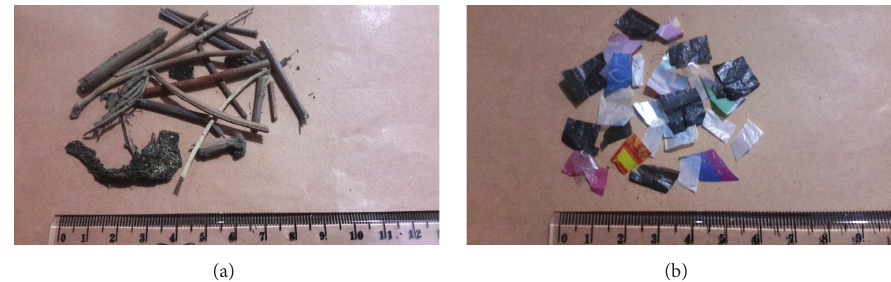
Figure 1: (a) Rough organic waste from a cutting machine and (b) pieces of